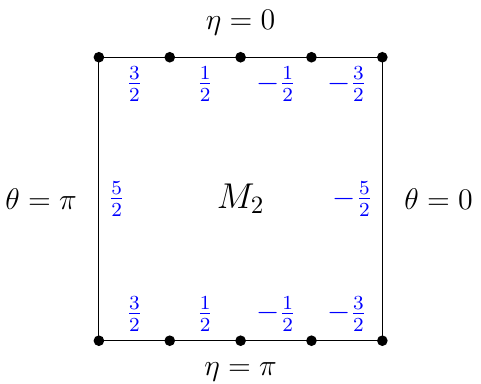
Figure 4 . Value that the function L takes (written in blue) in each boundary interval of M 2 separated by monopoles for the case of k = 5